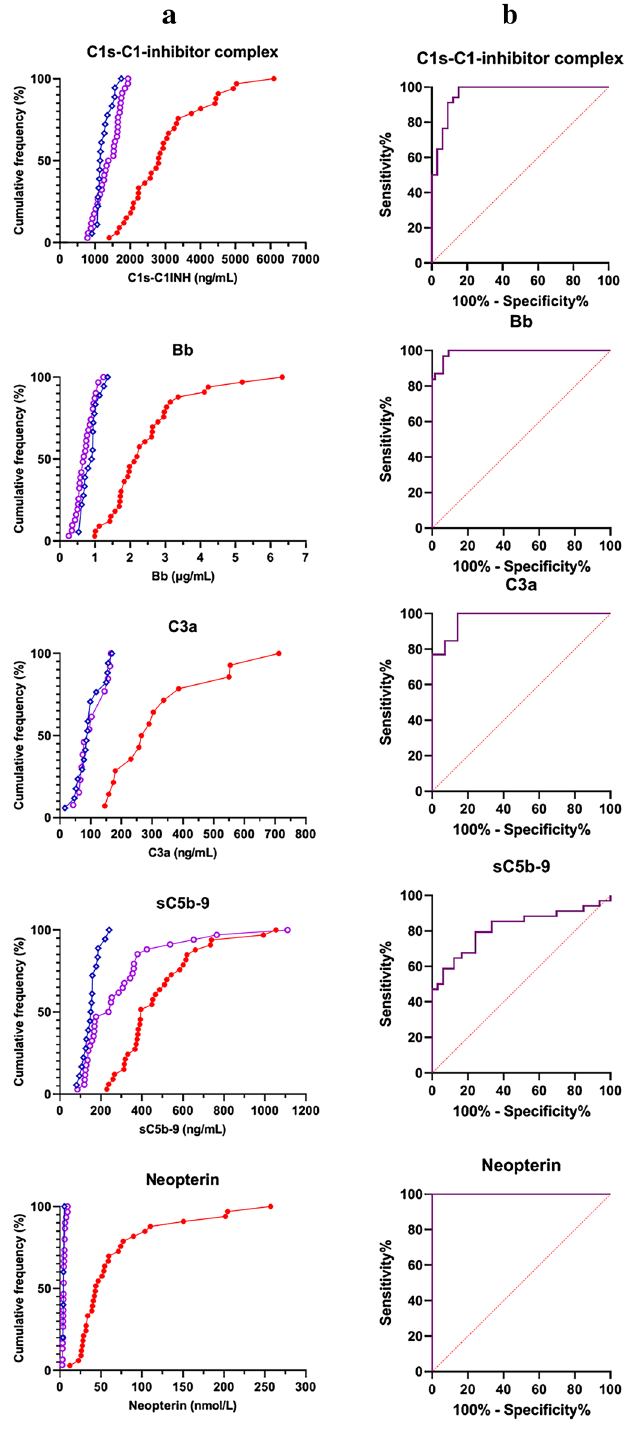
Figure 6. Ranking of complement and macrophage measures as markers of acute MIS-C and therapy response ( a ): Cumulative frequencies (%) of MIS-C cases in acute (red, solid circles) or in remission (purple, open circles) stage, and of healthy controls (blue, open rhombus), plotted against the range of selected complement- and macrophage activation markers. ( b ) : Performance of complement activation marker and neopterin levels to describe therapy responses in MIS-C (ROC-analysis). ( c ) : Area under the curve (AUC) values with 95% confidence